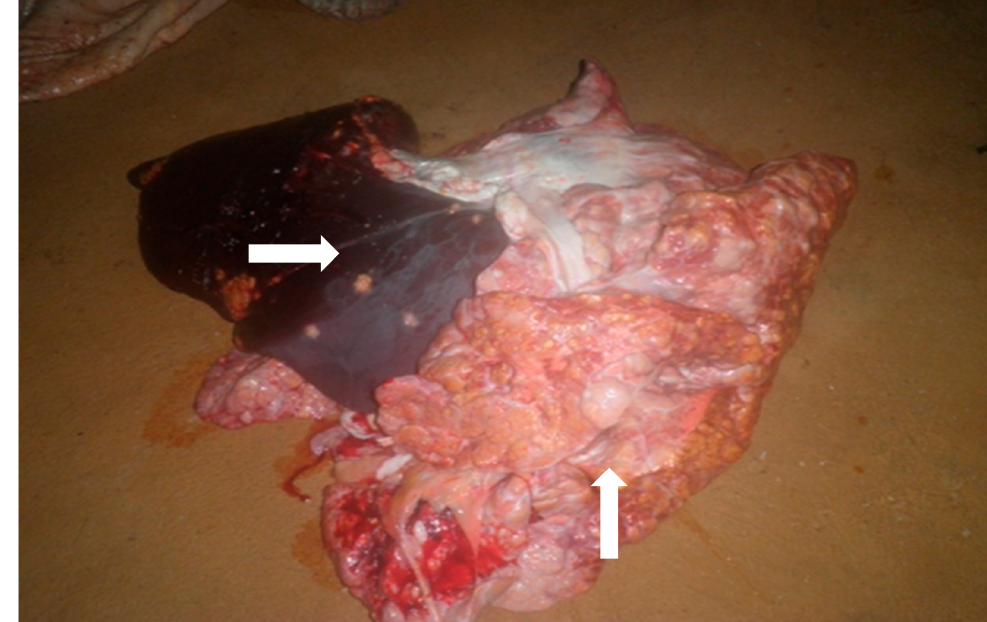
Figure 2. Gross appearance of granulomatous bTB suggestive lesions in the liver and lungs of a slaughtered cattle in Burkina Faso (indicated by white arrows). bTB = bovine tuberculosis.